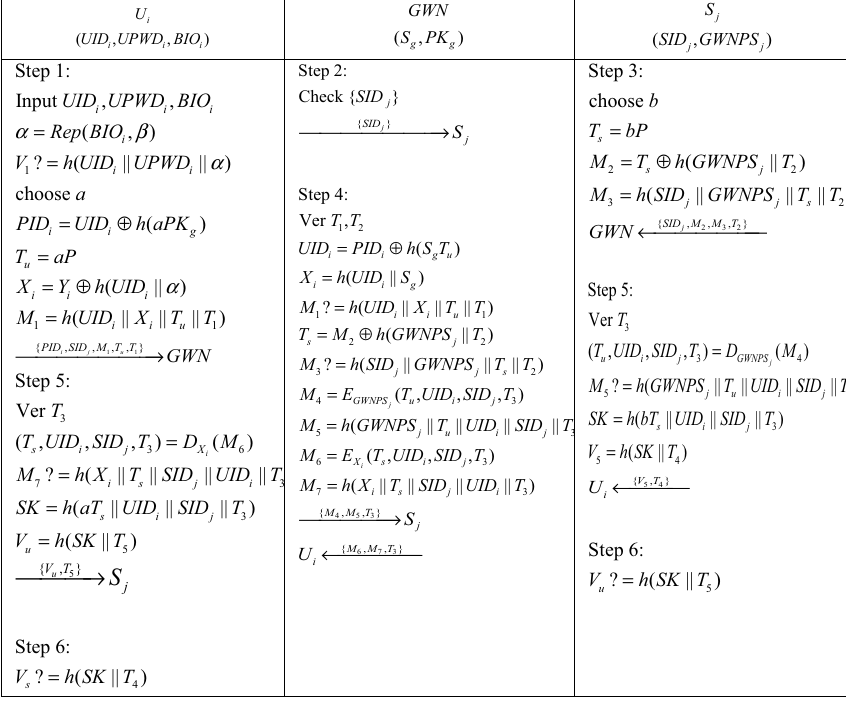
Algorithm 2: Authentication and key agreement